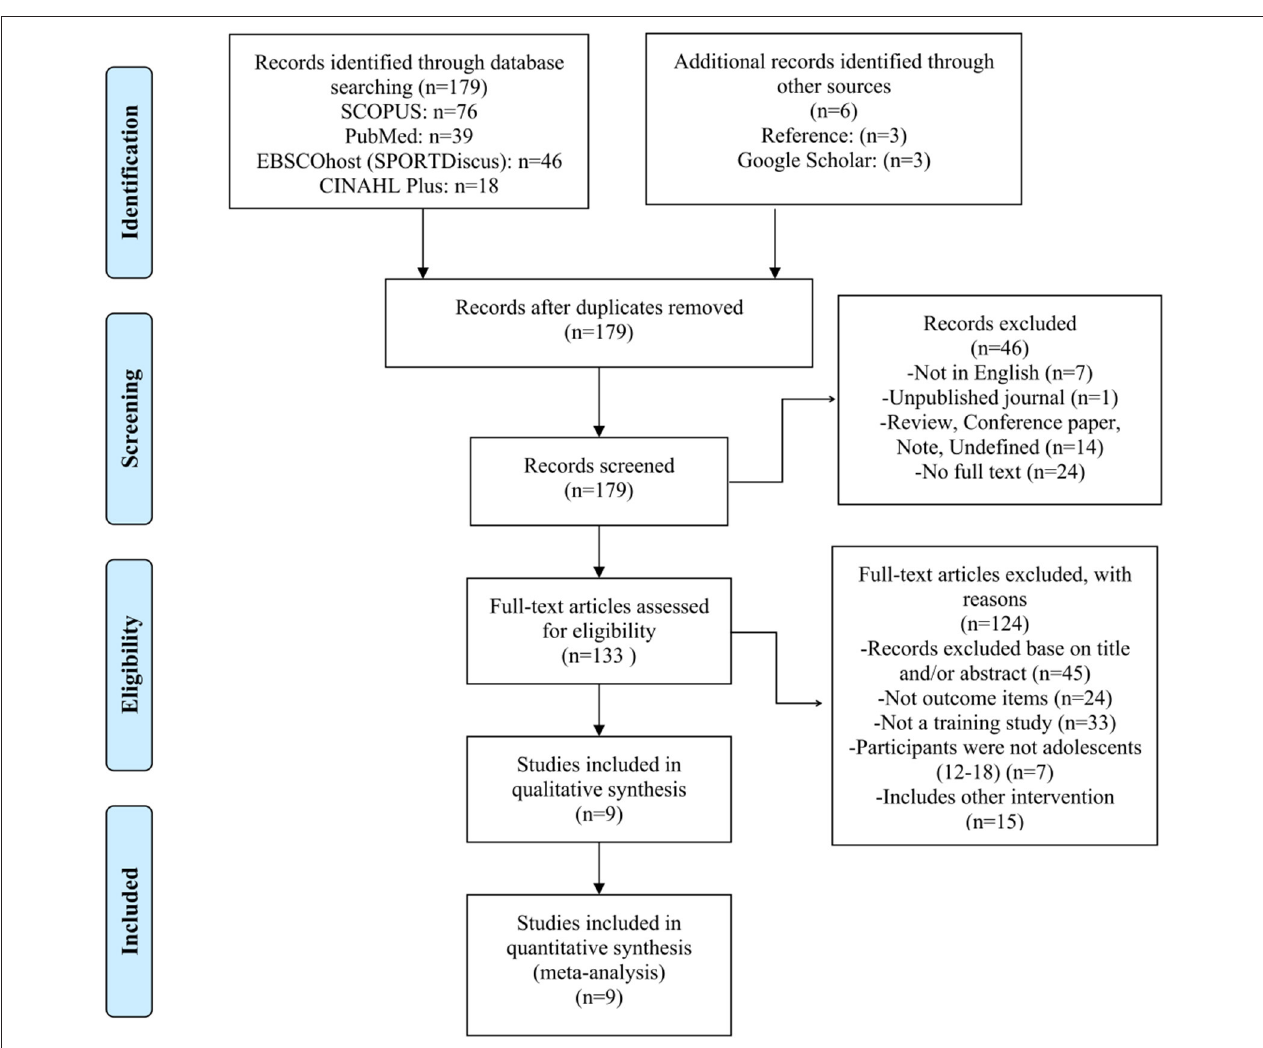
FIGURE 1 | The Preferred Reporting Items for Systematic Reviews and Meta-Analyses (PRISMA) flow diagram of the literature selection process.